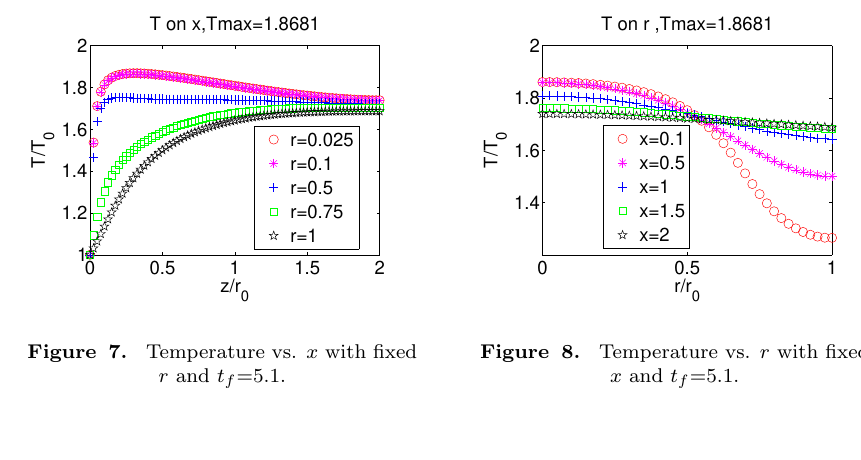
Figure 7. Temperature vs. x with fixed r and t f =5.1.